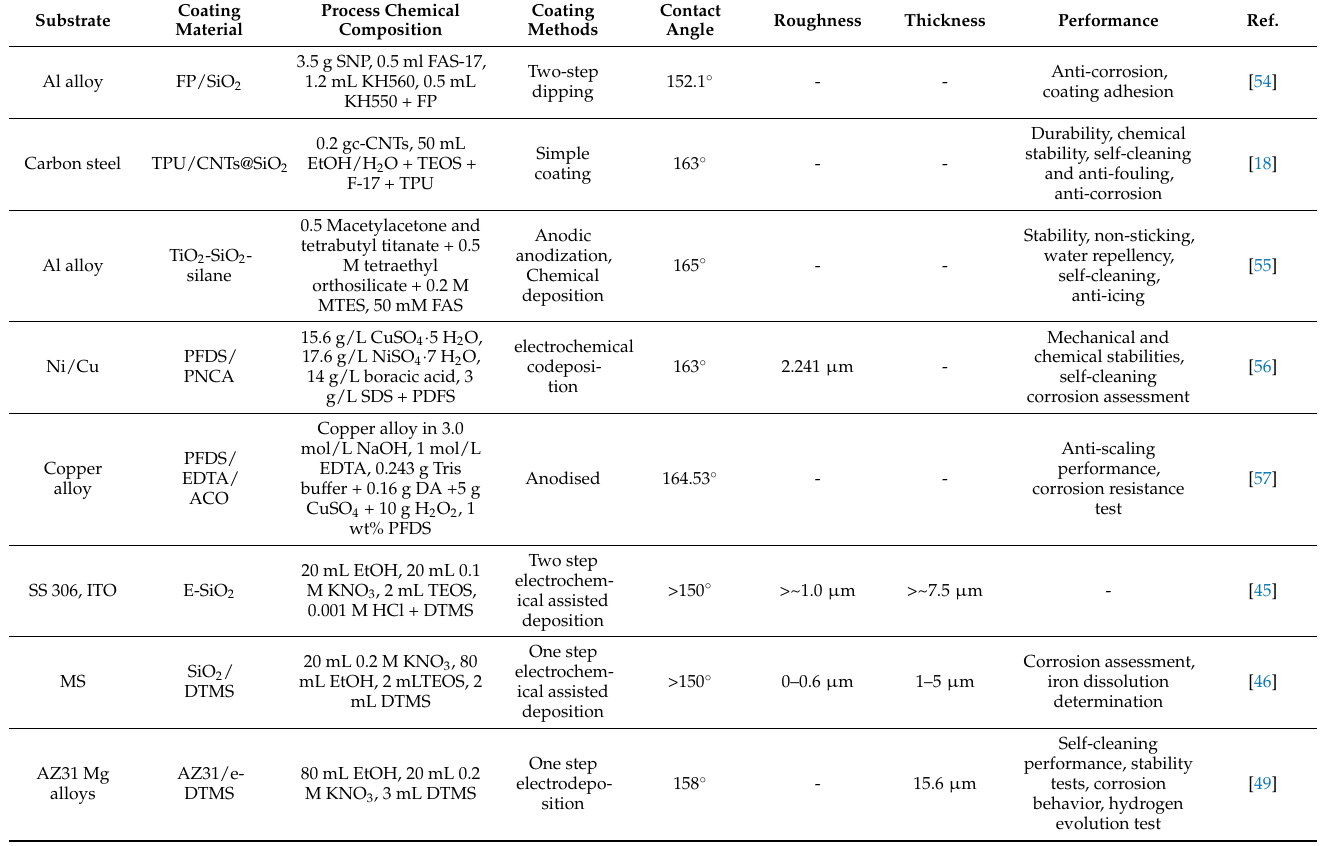
Table 2. Comparison of the properties and processes of several superhydrophobic coatings and this work by electrochemical techniques.